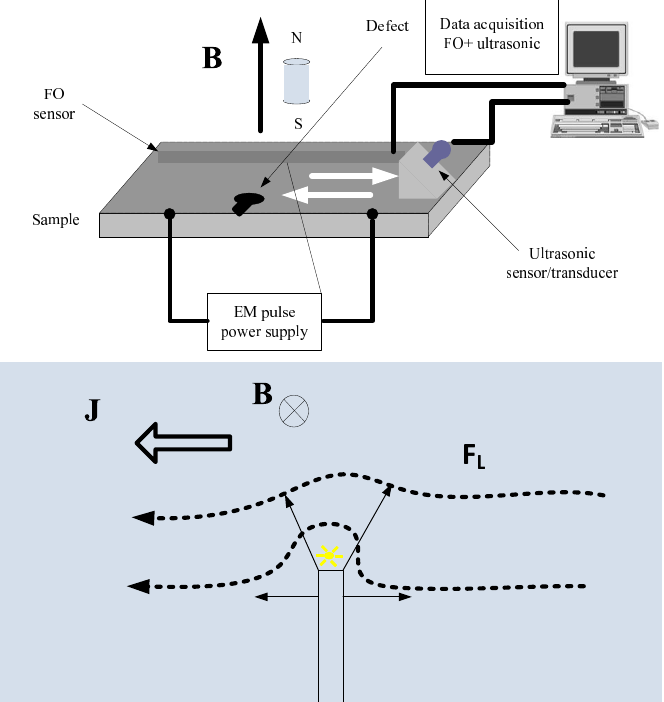
Figure 11. Experimental setup and schematic of the EMAT